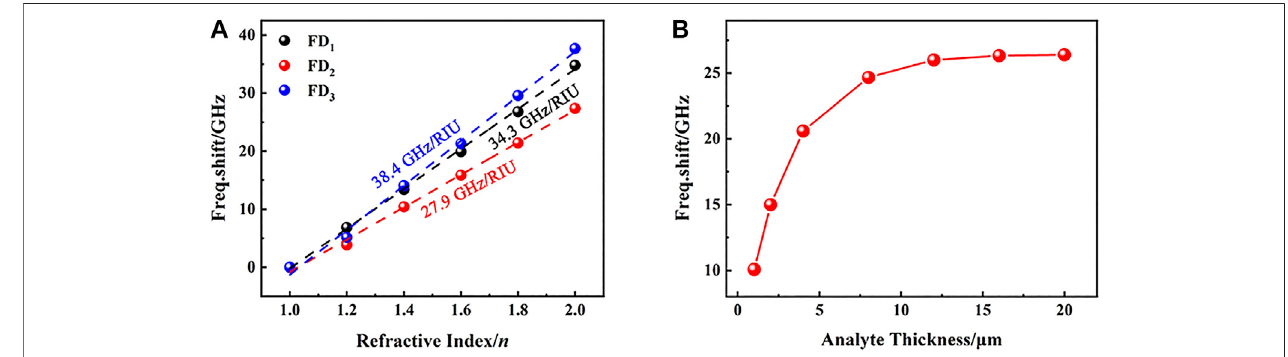
FIGURE 6 | (A) Frequency shift of FD 1 (black spheres), FD 2 (red spheres), and FD 3 (blue spheres) vs. refractive index. (B) Frequency shift of FD 3 vs. analyte